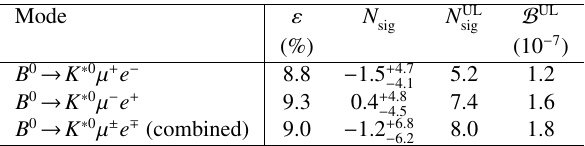
Table 3: Results from the fits. The columns correspond to the decay mode, e ffi ciency, signal yield, 90% C.L. upper limit on the signal yield, and 90% C.L. upper limit on the branching